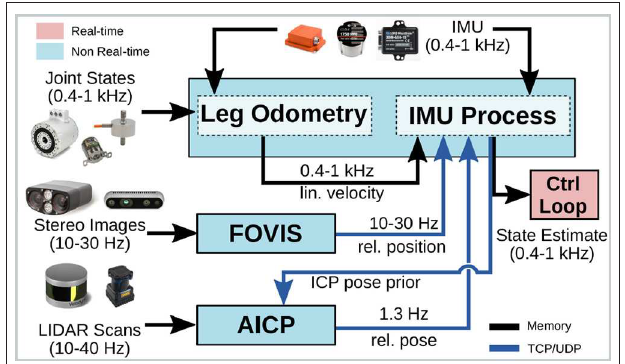
FIGURE 5 | Block diagram of our system: the IMU process model and leg odometry are run on the control computer in a real-time process (in pink), while the other modules run on separate computers in the user space (light blue). These modules output filter measurements as ROS messages, which are exchanged with the real-time domain through native shared memory mechanisms.